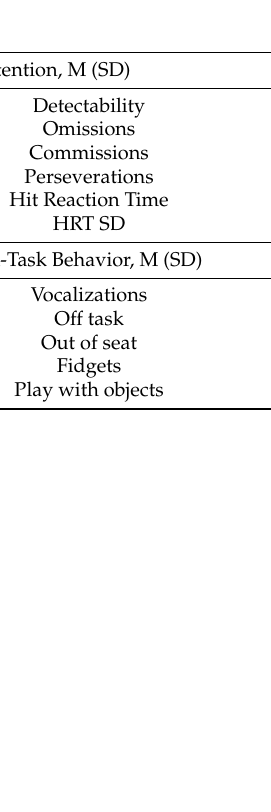
Table 4. Comparison of ADHD preschoolers’ performance between two background sound conditions. ADHD ( n =